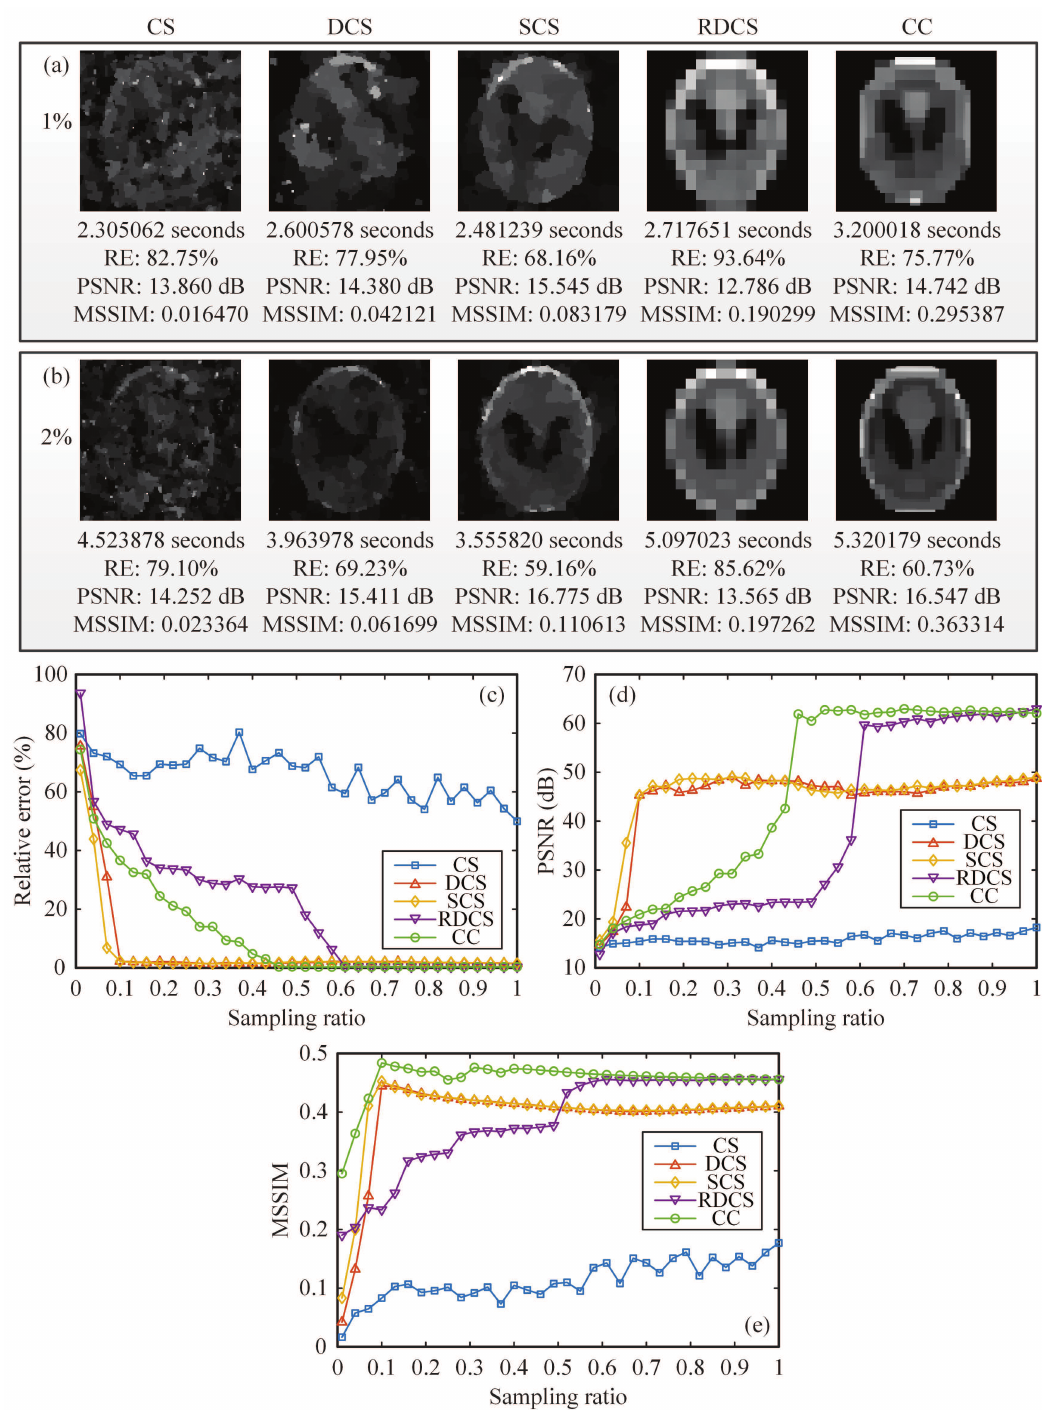
Figure 5. Comparison of the simulation results: ( a , b ) The reconstructions using CS, DCS, SCS, RDCS, CC method, with a sampling rate of 1% and 2%, respectively. The corresponding evaluation parameters such as the recovery time, relative error (RE) and peak signal-to-noise ratio (PSNR) are also given here. The recovery time can be shorter with some faster computers. ( c – e ) The comparison of above methods, in terms of RE, PSNR and MSSIM as a function of the sampling ratio. All images are of 128 × 128